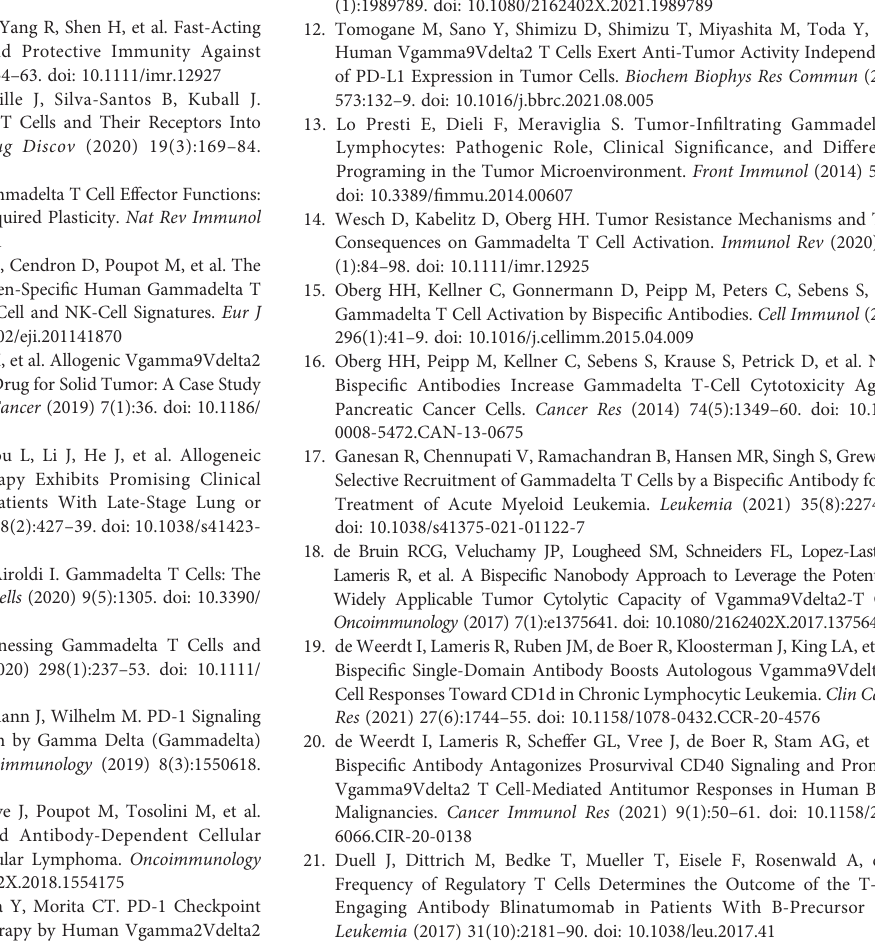
Supplementary Table 1 | Summary p values for Figures 2 , 3 , 5